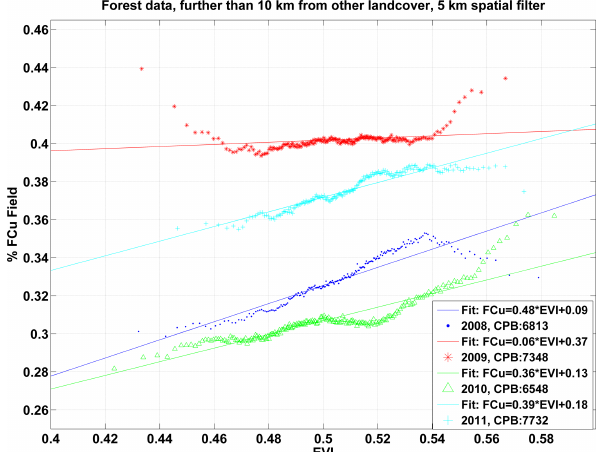
Figure 8. Four year (2008–2011) comparison of pFCu field as a function of EVI, for forest land cover data further than 10km from other land cover types, and sorted into 200 bins. A 5km spatial disk filter was applied to the EVI data. Counts per bin (CPB) and linear fits for all years added in figure